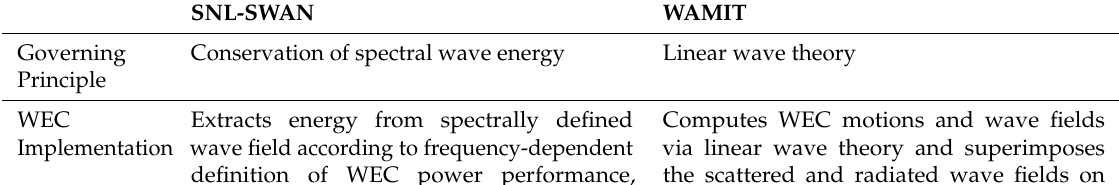
Table 1. Comparison of SNL-SWAN and WAMIT for computation of the wave energy converter (WEC) wave